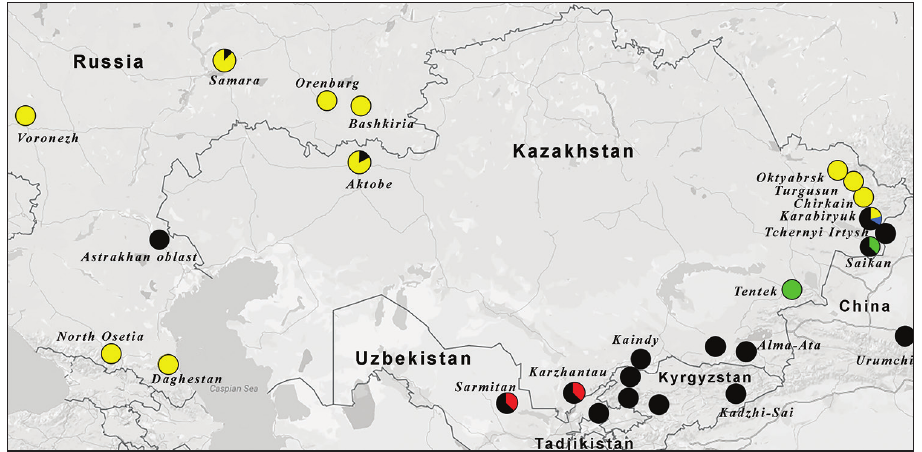
Figure 8. Localization of neera and turkestanica haplogroups (yellow circles – neera , black – turkestanica , green – turkestanica2 , red – turkestanica3 , blue – turkestanica4 )